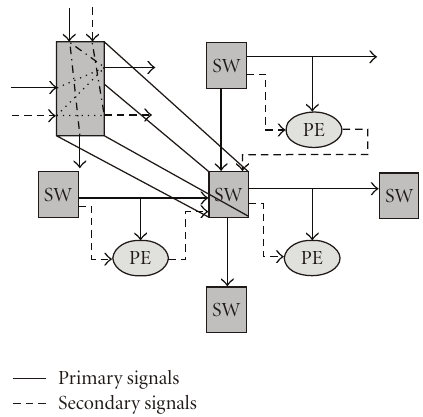
Figure 15: Connections between SW and PE cells.